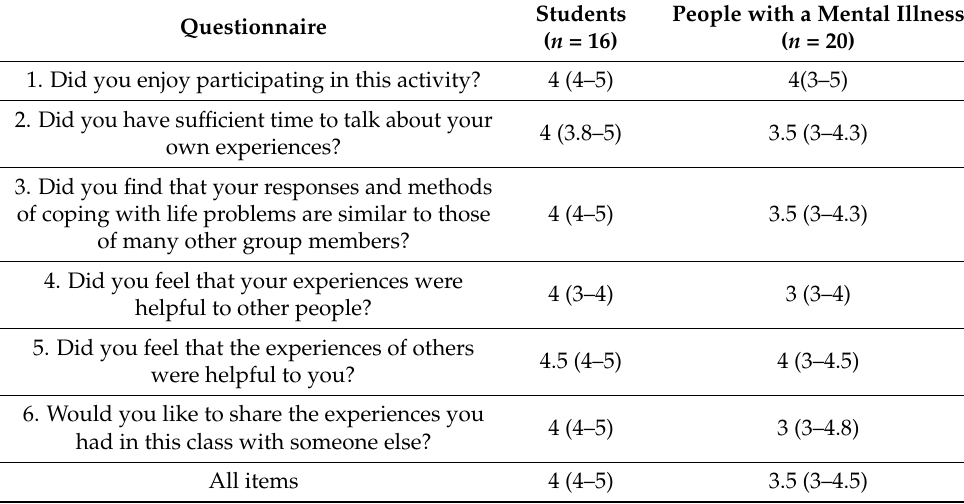
Table 5. Participants’ evaluations of the